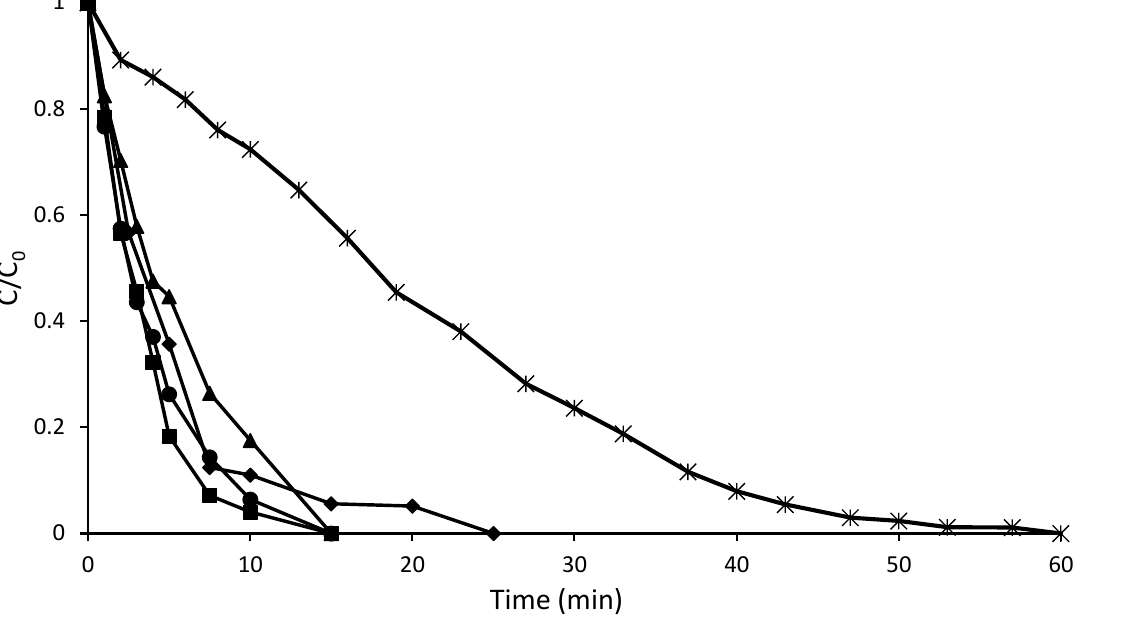
Figure 2. Plot of the relative concentration of acetaminophen (C/C 0 , where C 0 = 1 mg L − 1 ) when irradiated in the presence of a different concentration of H2O2: 0 mM ( X ), 11 mM ( (cid:7) ), 21 mM ( • ), 43 mM ( (cid:4) ) and 107 mM ( (cid:78)